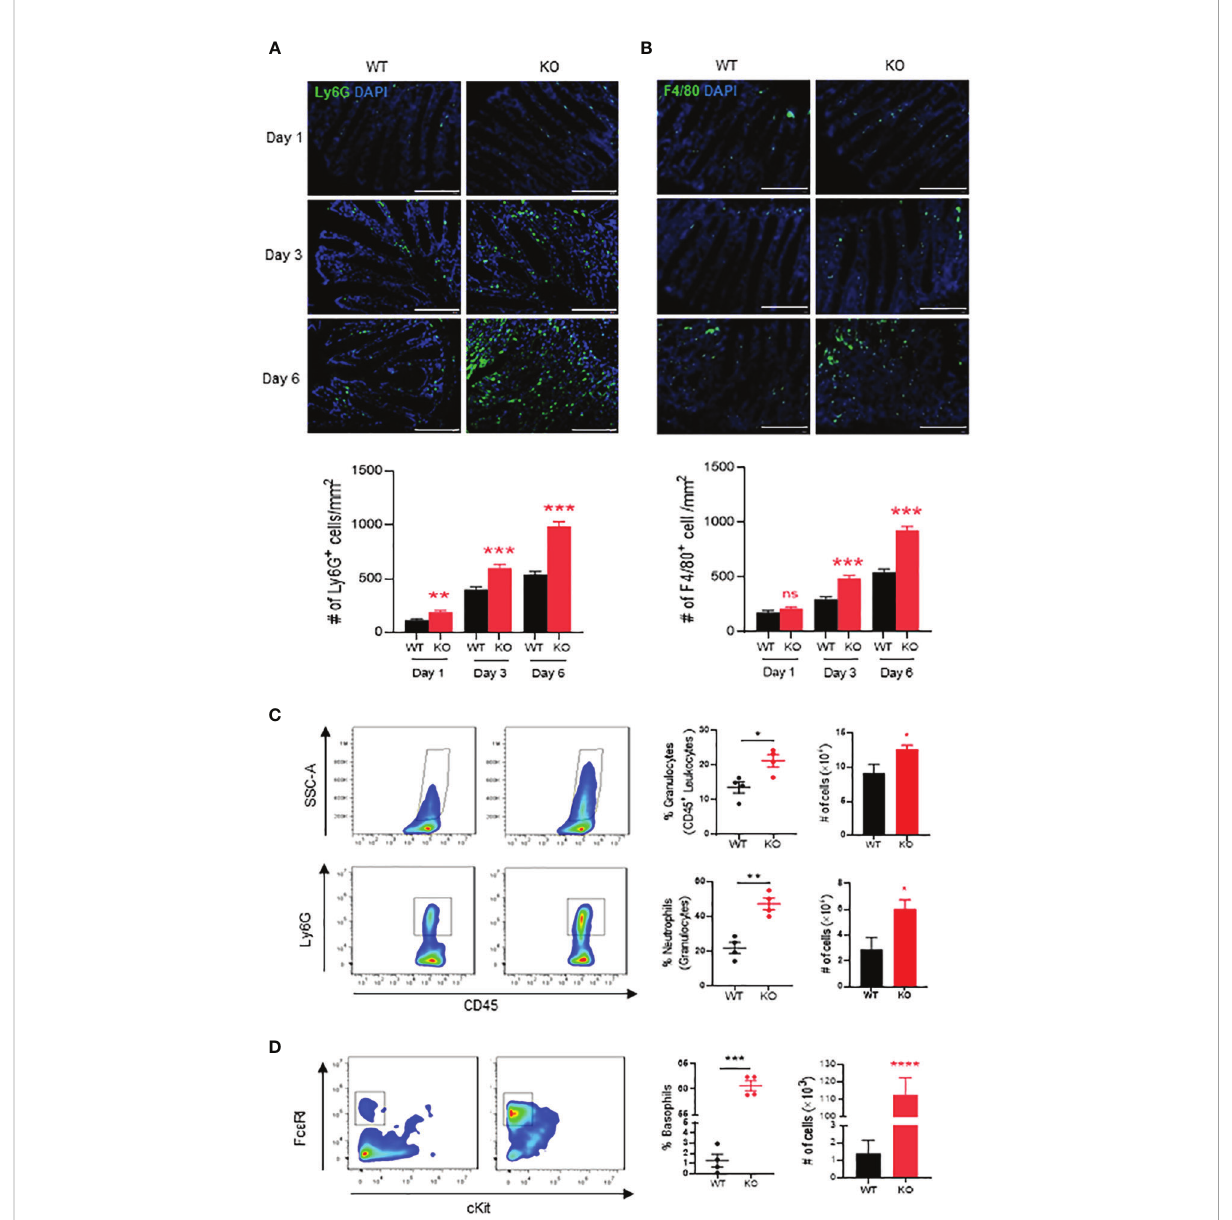
FIGURE 2 Neutrophils, macrophages and basophils in colon of AKR1B8 de fi cient mice under acute colitis. Immuno fl uorescent staining was used to evaluate innate immune cells in the colon mucosa during the course of acute colitis induced by DSS at 1.5%. (A) Ly6G + neutrophils. (B) F4/80 + macrophage. Lower panel , Ly6G + and F4/80 + cell number per mm 2 . Scale bar, 100 m m. Thereafter, fl ow cytometry was used to con fi rm the innate immune cell changes as described in Materials and Methods. (C) granulocytes (SSC-A high CD45 + ; upper panel ) and neutrophils (SSC-A high CD45 + Ly6G + ; lower panel ). (D) basophils (SSC-A high CD45 + c-Kit - FC ϵ RI + ). From left to right , fl ow cytometry images, percentage and absolute number of cells. KO, knockout; WT, wild type. *p < 0,05; **p < 0.01; ***p < 0.001 and ****p < 0.0001; ns, No Signi fi